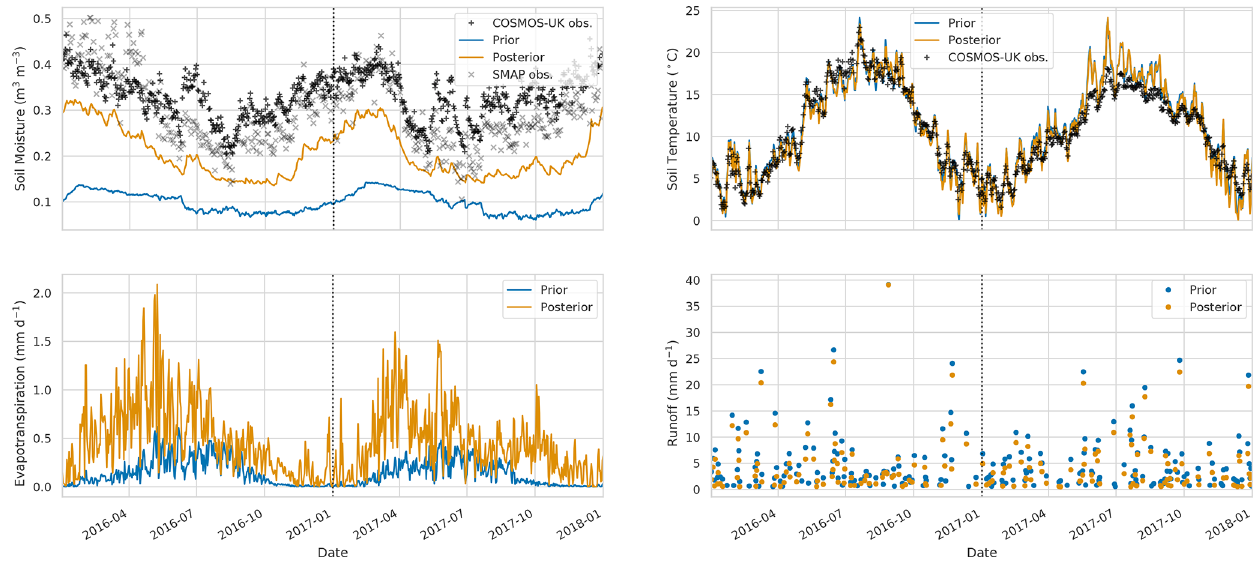
Figure 13. Time series of water budget variables and soil temperature at Stoughton COSMOS site. Black plus signs: COSMOS-UK ob- servations, grey crosses: SMAP observations for closest 9km pixel, blue line: prior JULES estimate for closest 1km grid cell, orange line: posterior JULES estimate for closest 1km grid cell.